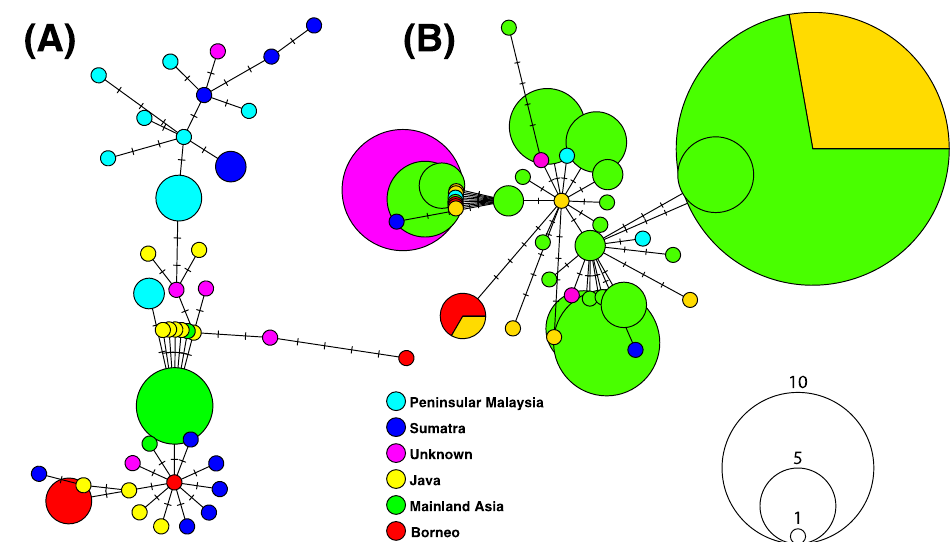
Figure 4. Haplotype networks reconstructed based on 98 and 50 DNA barcodes available for B. gonionotus ( A ) and B. schwanefeldii ( B ), respectively. Numbers of changes are indicated by small segments on links. Circles represent haplotypes; the size of a circle is proportional to the haplotype